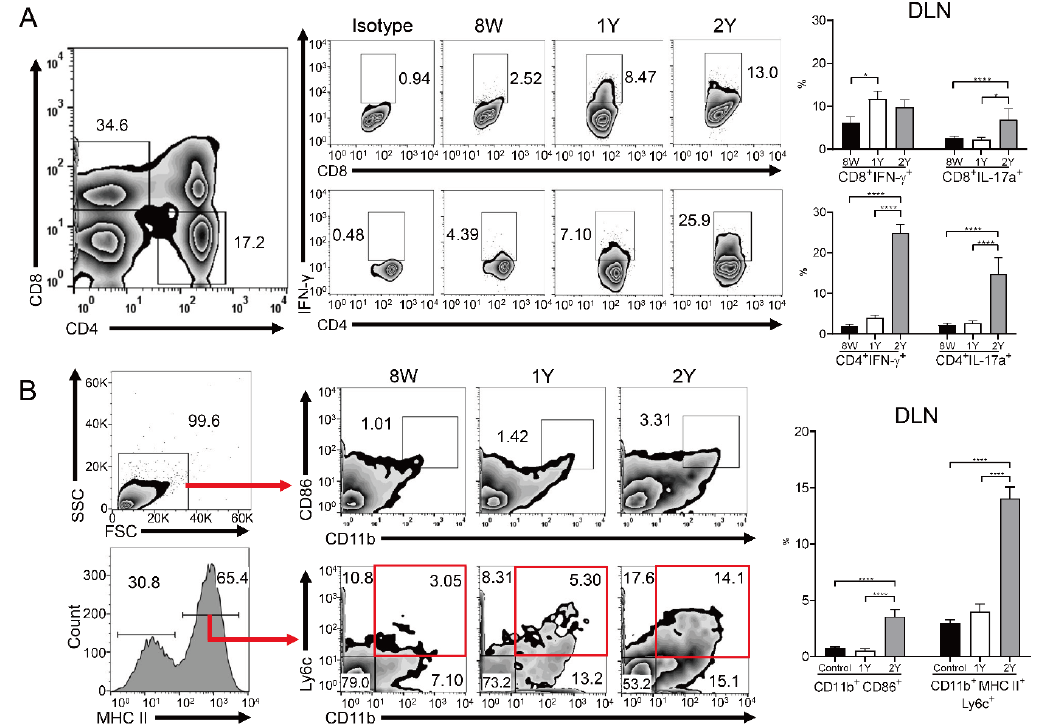
Figure 6. Flow cytometry for immune cells in the drainage lymph nodes (DLNs). ( A ) In DLNs,